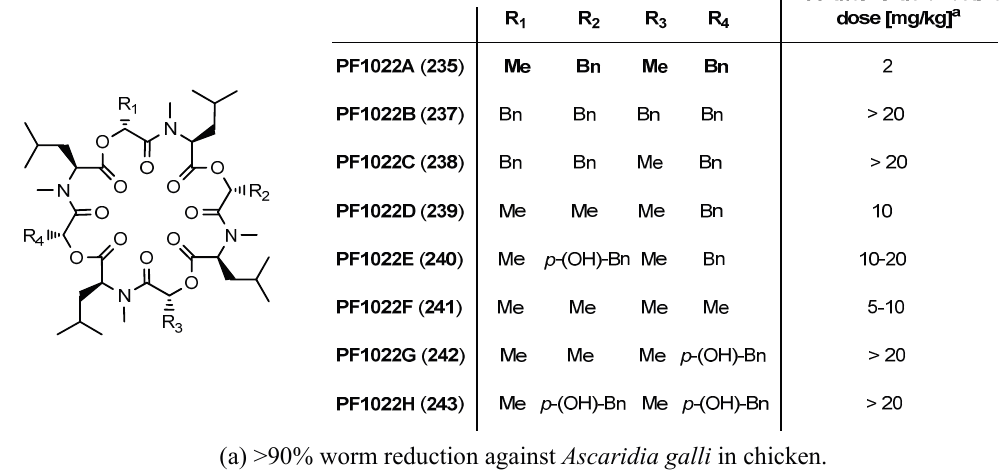
Figure 27. PF1022A and analogues 237 – 243 isolated from the fermentation broth.